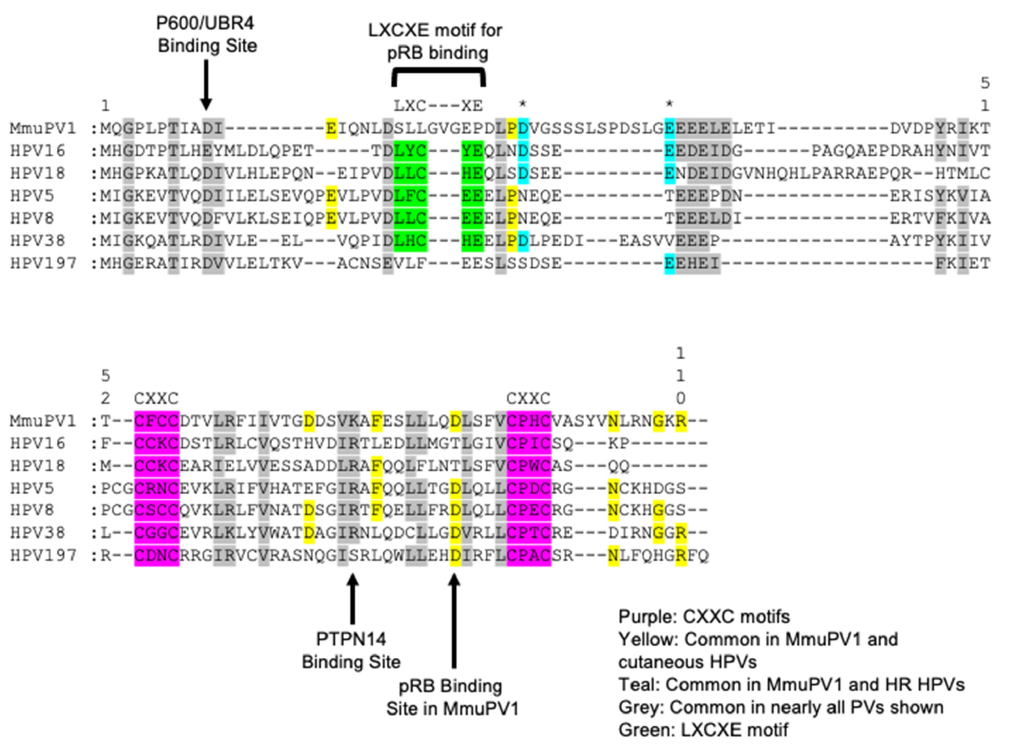
Figure 2. Alignment of the MmuPV1 E7 protein to cancer associated HPV E7 proteins. An amino acid sequence alignment was performed comparing the MmuPV1 E7 protein to various cancer associated HPV genotypes including the high-risk HPV 16 and 18, EV-associated β -HPV 5, 8, and 38, and the cutaneous γ -HPV 197. Like the caner associated HPV E7 proteins, MmuPV1 E7 contains two CXXC zinc binding motifs present in the C-terminal domain (highlighted in purple). MmuPV1 E7 does not contain an LXCXE motif like the high-risk and cutaneous β -HPVs used in this alignment (highlighted in green). A number of amino acids are shared between the various papillomavirus E7 proteins in particular in between the C-X-X-C motifs (highlighted in grey). As expected, a number of amino acids are shared with the cutaneous HPVs used in this alignment (highlighted in yellow). Interestingly, there were a couple of amino acids that were present in MmuPV1 that were more likely to be present in the high-risk HPV E7 oncogenes compared to the cutaneous HPV E7 onco- genes (highlighted in teal and asterisk above). This alignment again provides some evidence that MmuPV1 E7 is more closely related to the cutaneous HPV genotypes than the high-risk HPV geno- types. A few notable binding sites for E7 are noted with arrows including the amino acids respon-